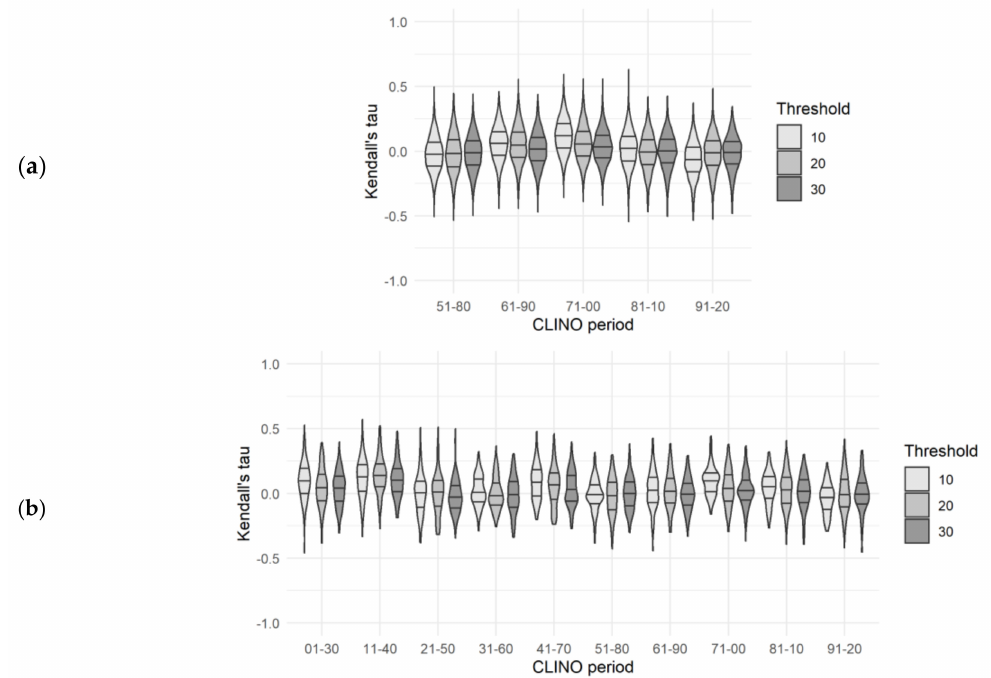
Figure 2. Distribution of Kendall’s tau for the CLINO periods with thresholds for heavy rainfall days in mm d − 1 . ( a ) all stations and ( b ) the 111 stations with 9–10 trend values. The lines represent the median as well as the 25% and 75%